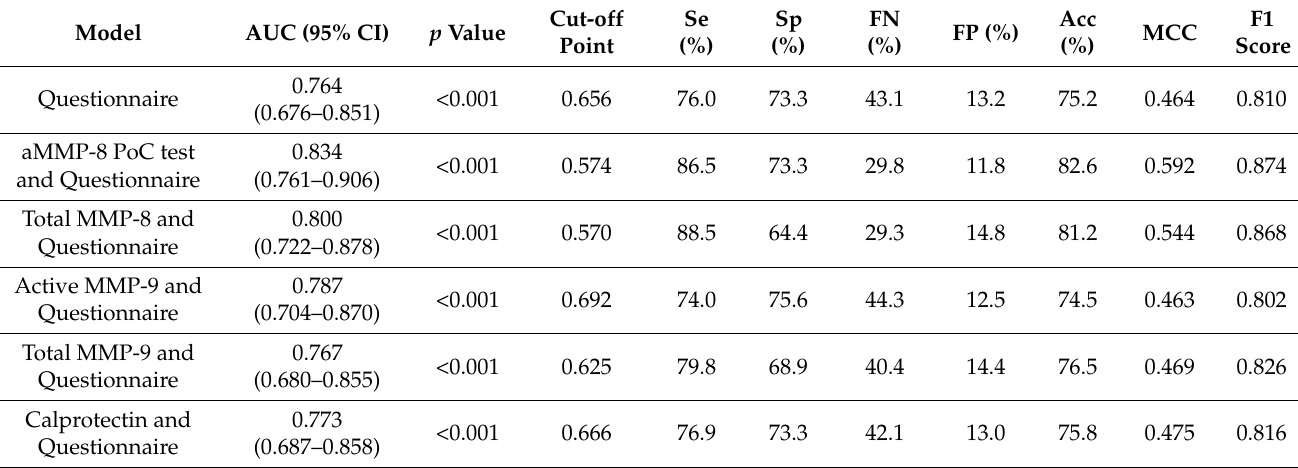
Figure 1. Receiver operating curve (ROC) analysis regarding using questionnaire and biomarkers ( aMMP-8 , total MMP-8 , active MMP-9 , total MMP-9 and calprotectin) to identify undiagnosed periodontitis (Stages II–III) (n = 149 Greek patients, as described previously [2,3,24]). ( A ) A plain questionnaire vs. a questionnaire adjunct with aMMP-8 , total MMP-8 , or calprotectin, and ( B ) a plain questionnaire vs. a questionnaire adjunct with aMMP-8 , active MMP-9 , or total MMP-9 . Questionnaire includes patient’s gender, age, education level, smoking and body mass index (BMI). Table 1. Diagnostic potential of a questionnaire and biomarkers (aMMP-8, total MMP-8, active MMP-9, total MMP-9 and calprotectin) to identify periodontitis (Stages II–III). The Youden index was used defining the optimal cut-offs for each logistic regression model from the ROC